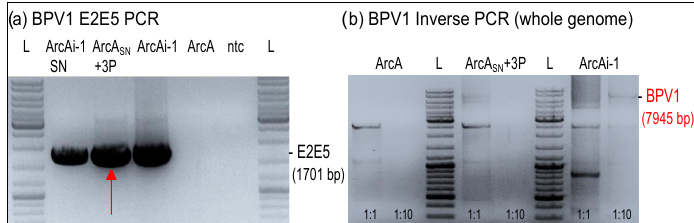
Figure 6. Transmission of BPV1 DNA by culture medium as revealed by BPV1 PCR. BPV1 E2E5 ( a ) and inverse PCR ( b ) from cell-free culture supernatant of ArcAi-1 (ArcAi-1 SN), ArcA cells exposed to this supernatant and then passaged for tree times (ArcA SN + 3P), BPV1 infected ArcA cells (ArcAi-1; positive control), native ArcA (ArcA; negative control), and sterile water (ntc). L: GeneRuler DNA Ladder Mix (Thermo Fisher Scientific).